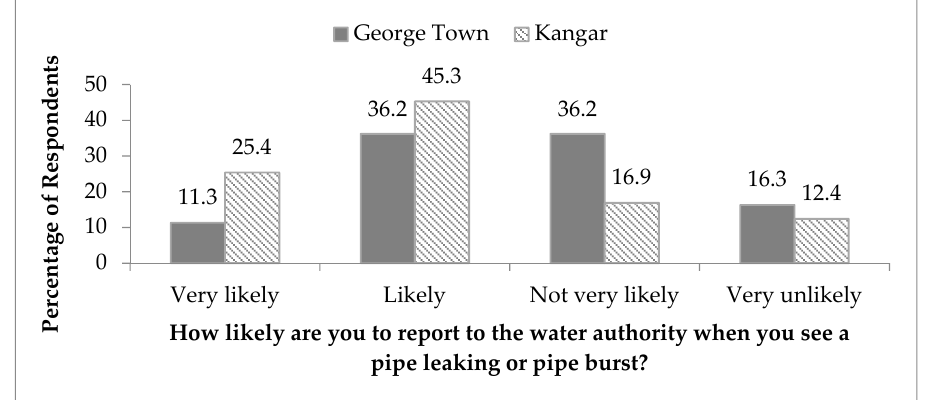
Figure 6. Behaviour towards pipe leaking or pipe burst issue.